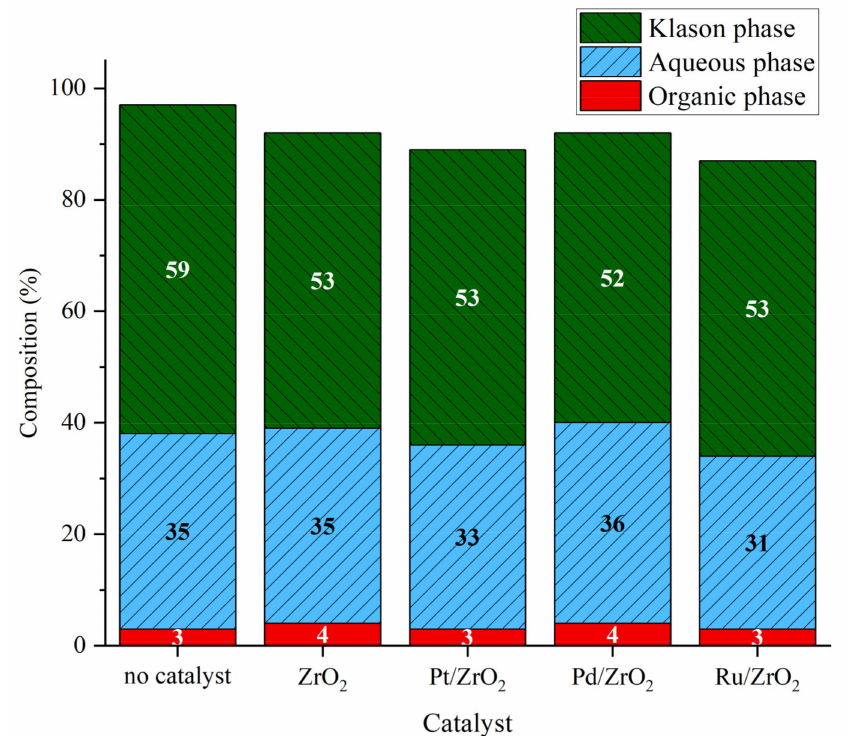
Figure 6. Phases composition after lignin catalytic liquefaction over metal catalysts. Reaction conditions: Kraft lignin 10 g · L − 1 , mass ratio Pt/lignin 1/100 or molar equivalent, 3 h, 225 ◦ C, 40 bar